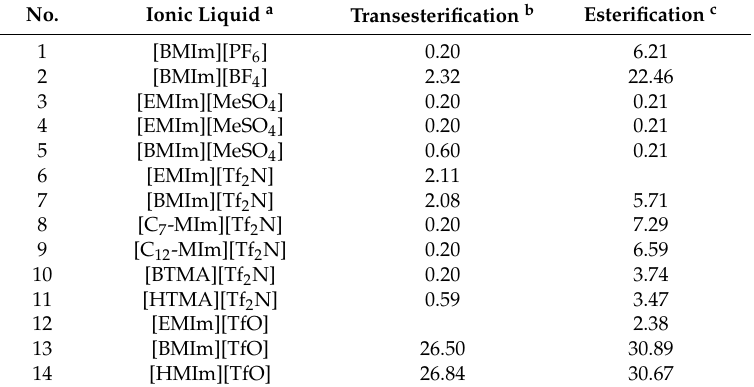
Table 1. Conversions (%) obtained by Lipozyme TLIM-catalyzed transesterification and Novozym 435-catalyzed esterification in 14 different ionic liquids